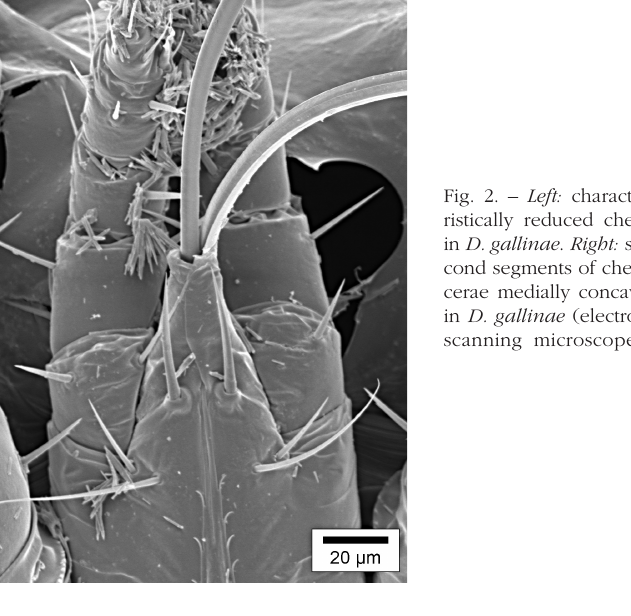
Fig. 2. – Left: characte- ristically reduced chela in D. gallinae . Right: se- cond segments of cheli- cerae medially concave in D. gallinae (electron scanning